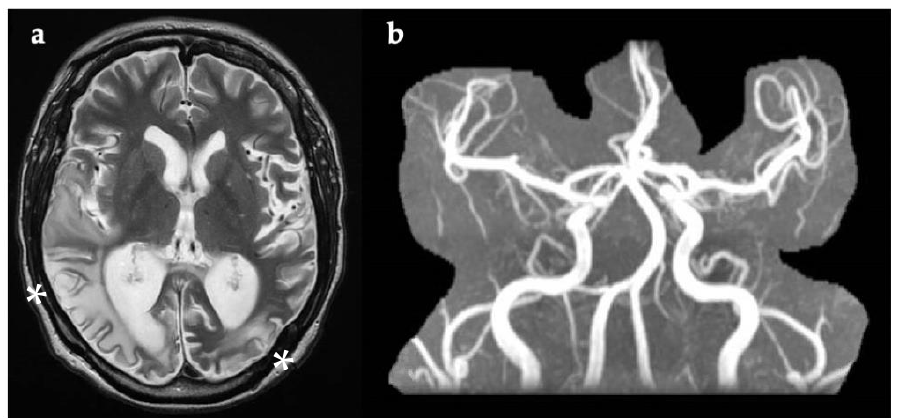
Figure 4. ( a ) Axial brain MRI image taken four days after symptom onset, showing multiple areas of white matter and cortical increased T2w signal within the posterior cerebral hemispheres (white asterix). DWI is not available. ( b ) Normal MRA with no evidence of narrowing of blood vessels, as usually present in CNS vasculitis. DWI, diffusion-weighted imaging; MRA, magnetic resonance angiography; T2w, T2-weighted imaging.